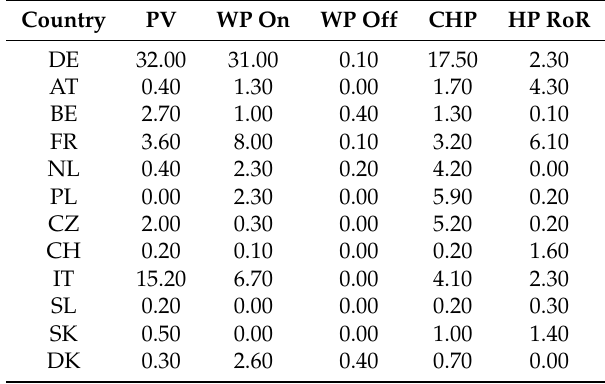
Table 4. Capacity of non-dispatchable generation in GW